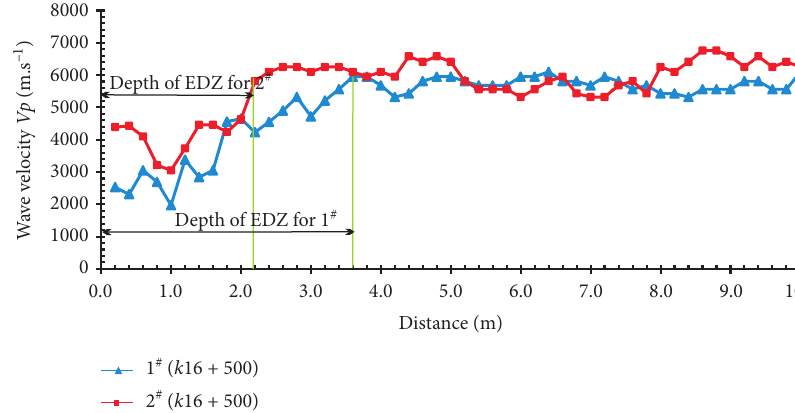
Figure 5: Typical acoustic monitoring results.